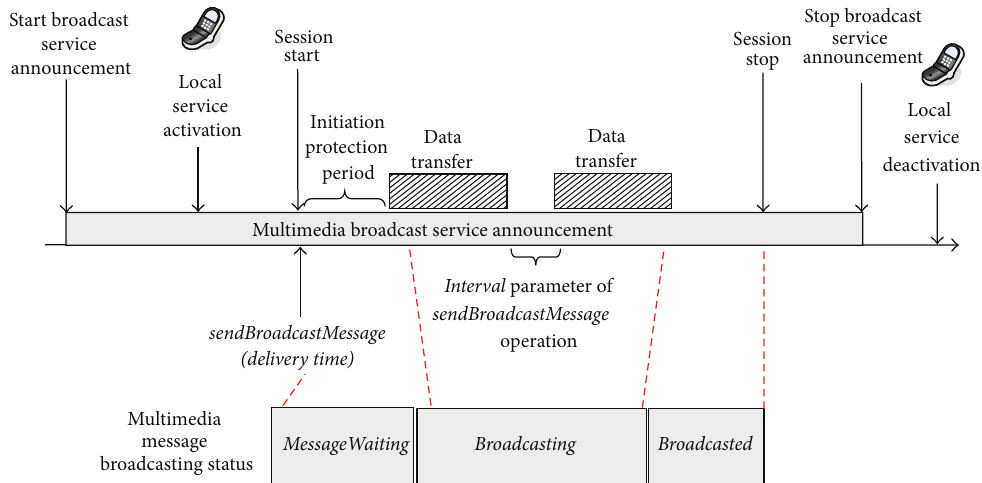
Figure 2: Multimedia broadcast service time line and the parameters of sendBroadcastMessage operation.